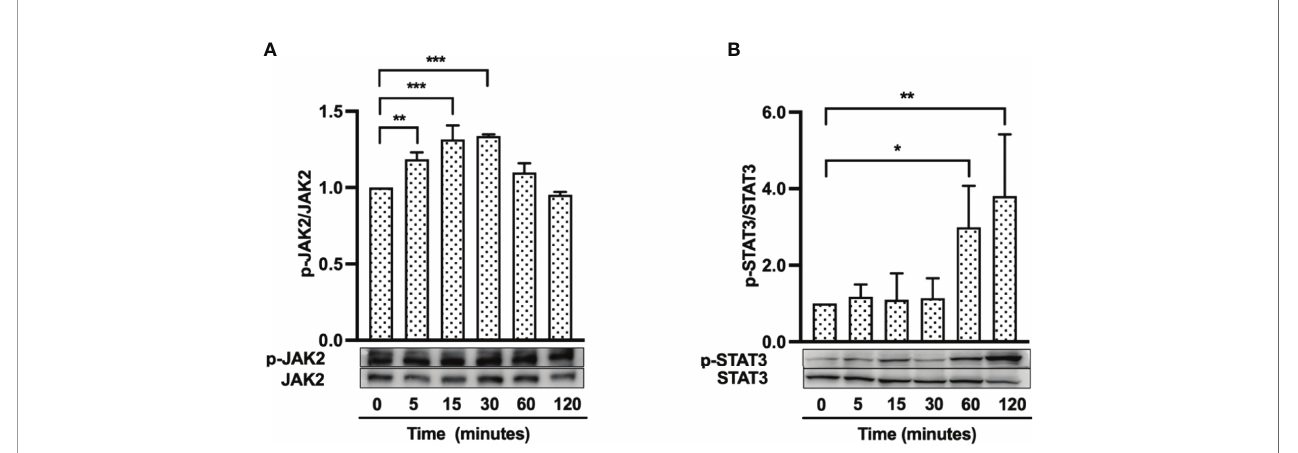
FIGURE 7 | hBD-3 enhances phosphorylation of JAK2 and STAT3. Fibroblasts were stimulated with 20 µg/ml hBD-3 for 5 minutes to 120 minutes and subjected to Western blotting using antibodies against phosphorylated or unphosphorylated JAK2 (A) and STAT3 (B) . Bands were quanti fi ed using densitometry. The P value was calculated using one-way ANOVA with Tukey ’ s multiple comparisons test. * P < 0.05, ** P < 0.01, and *** P < 0.001 for comparisons between the nonstimulated (0 minutes) and hBD-3-stimulated cells. n =